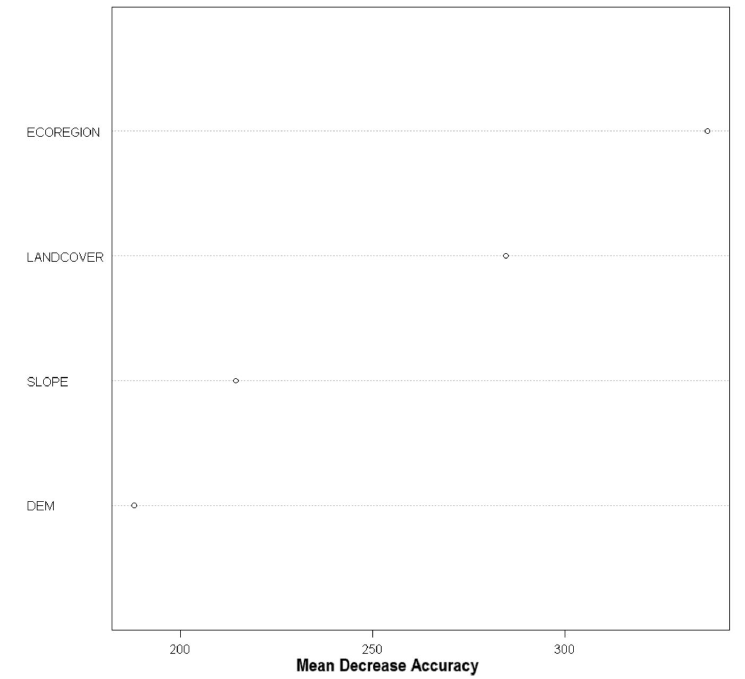
Figure 15. RF variable importance analysis for San Ignacio de Velasco based on the Mean Decrease